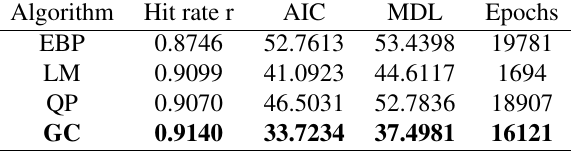
Table 12. Stage 4. Results obtained for the learning algorithms